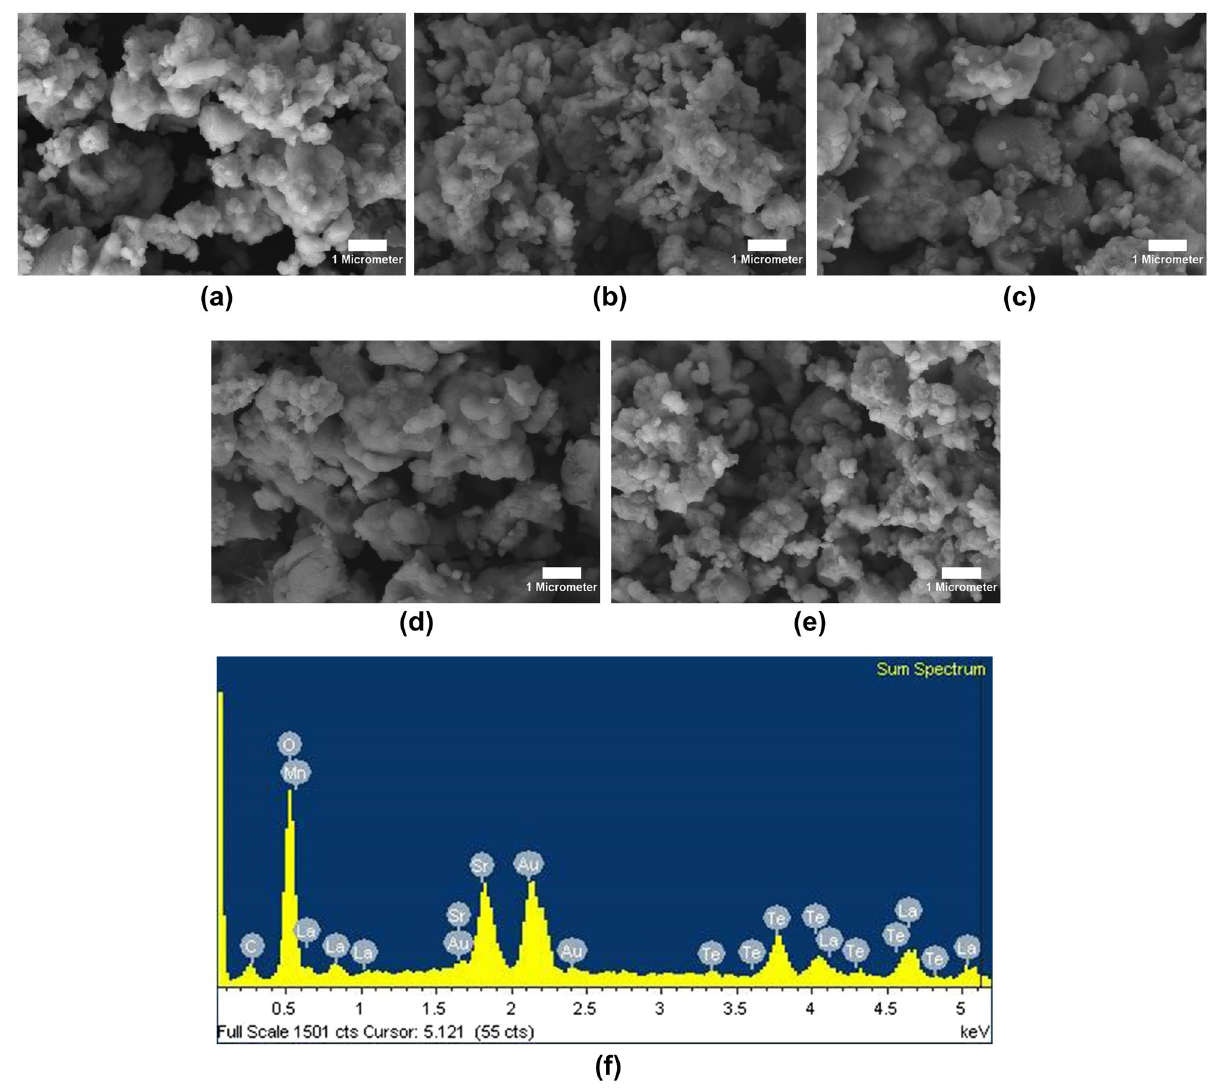
Figure 4. FESEM images (10 K magnification) of SrLaLiTe 1− x Mn x O 6 in powder form and EDX plot of x =